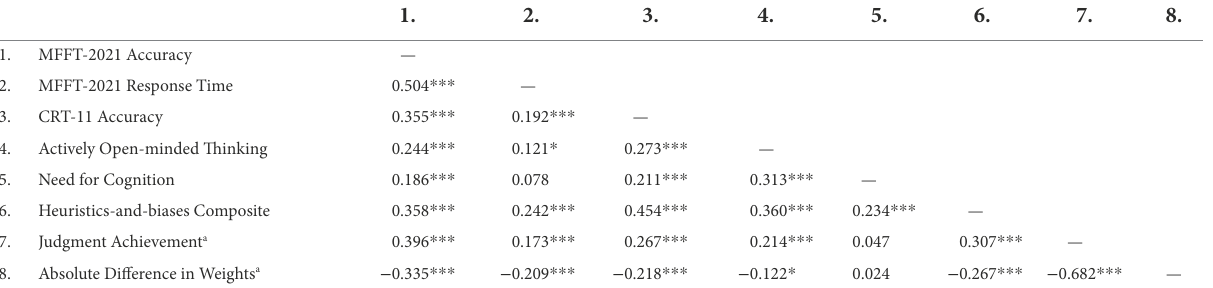
TABLE 2 Study 1 Means, SDs, and zero-order correlations.